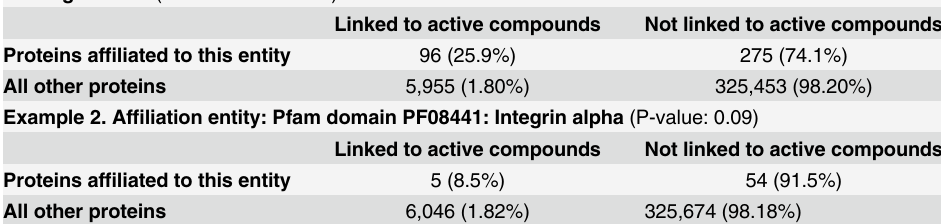
Table 4. Weighting the functional affiliations of proteins based on their association to bioactive com- pounds. The table lists two examples of affiliation-type entities (Pfam domains), and their respective contin- gency tables used to evaluate the significance of association of proteins containing these Pfam domains to bioactive compounds, using Fischer ’ s exact test. Calculation of P-values was done for all affiliation-type enti- ties in the network (Pfam domains, Ortholog groups, and metabolic pathways) using this methodology. Scores used to weight network edges were derived directly from P-values using a simple transformation (see